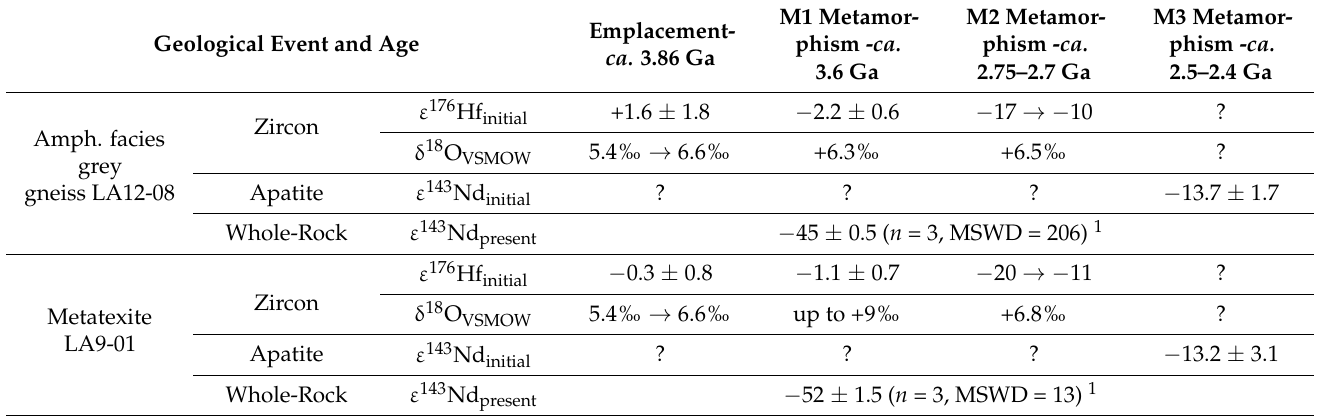
Table 2. Summary of zircon U–Pb/Hf/O and apatite U–Pb/Sm–Nd isotopes LASS analyses and whole-rock Sm–Nd isotopes analyses conducted on the amphibolite grey gneiss facies LA12-08 and the metatexite LA9-01. Zircon isotopes analyses are from [5]. 1 : the meaning of whole-rock Sm–Nd isotopes results is discussed in the